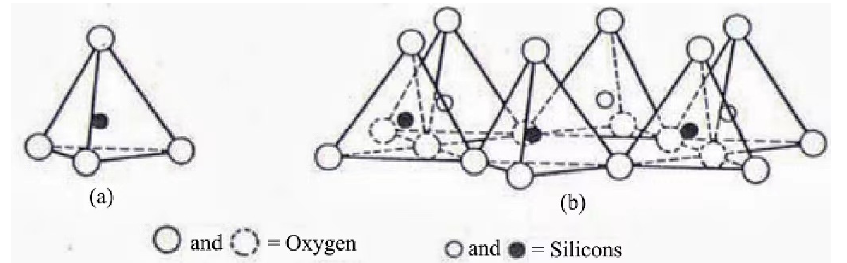
Figure 3. ( a ) Si location in tetrahedral; ( b ) silica sheet. Reprinted with permission from Ref. [4].